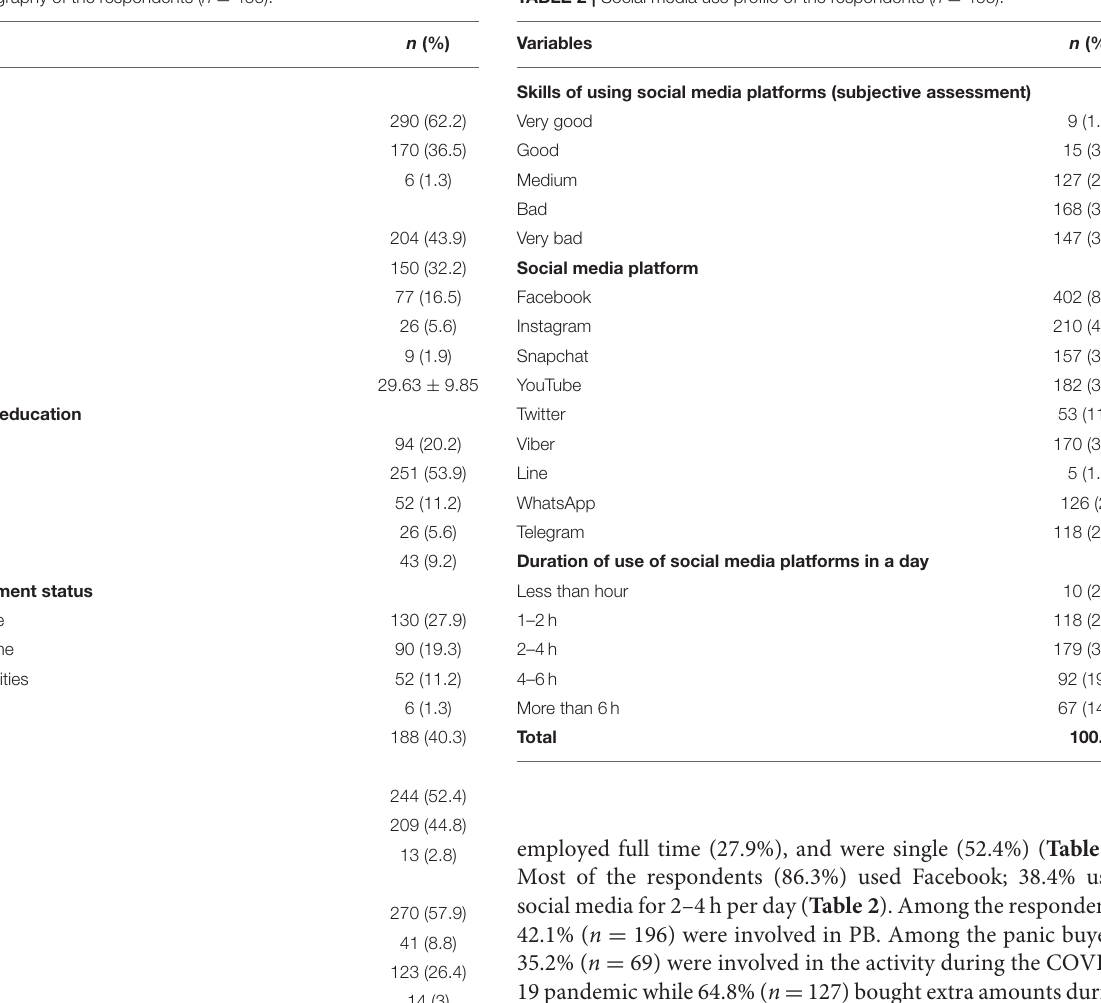
TABLE 1 | Demography of the respondents ( n = 466). TABLE 2 | Social media use profile of the respondents ( n =